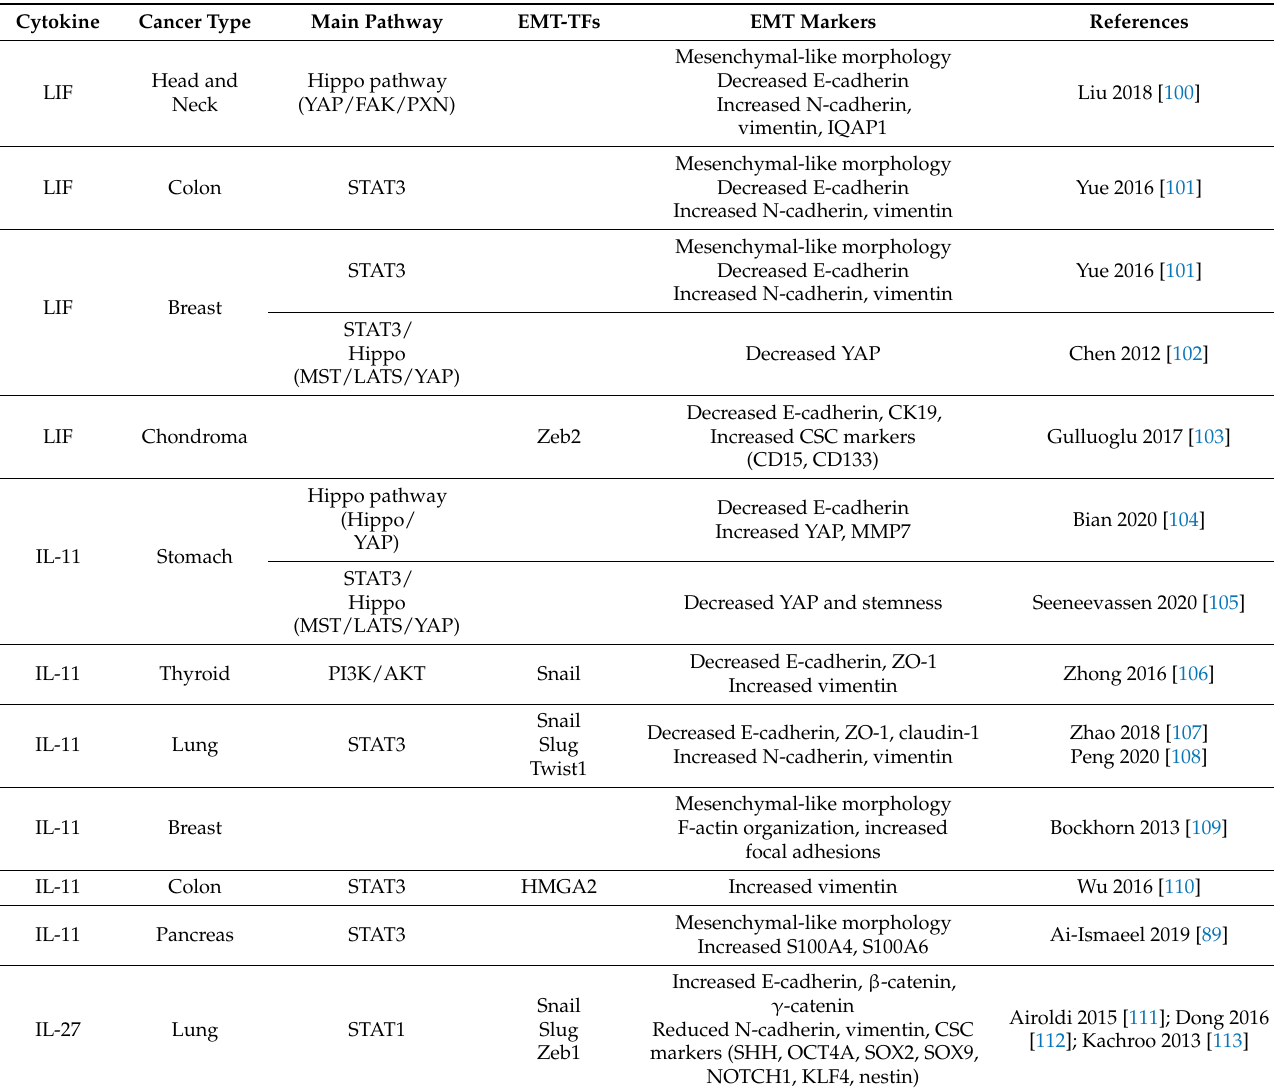
Table 3. Experimental evidence of the implication of leukaemia inhibitory factor (LIF), interleukin 11 (IL-11) and 27 (IL-27) on epithelial–mesenchymal plasticity (EMP) in